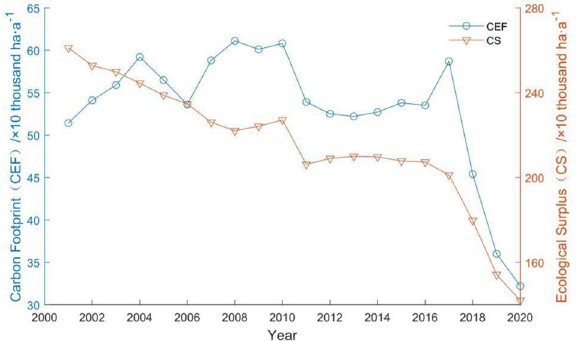
Figure 6. Inter-annual variation of carbon footprint and ecological surplus of farmland ecosystems in Guangdong.